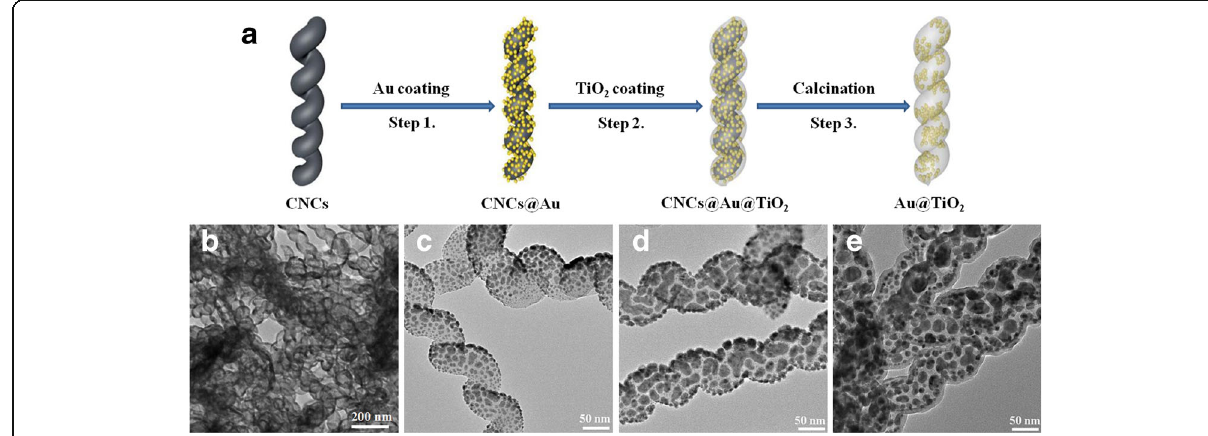
Fig. 1 a Schematic illustration of the synthetic process of Au-x@TiO 2 . b – e TEM images reveal the morphological